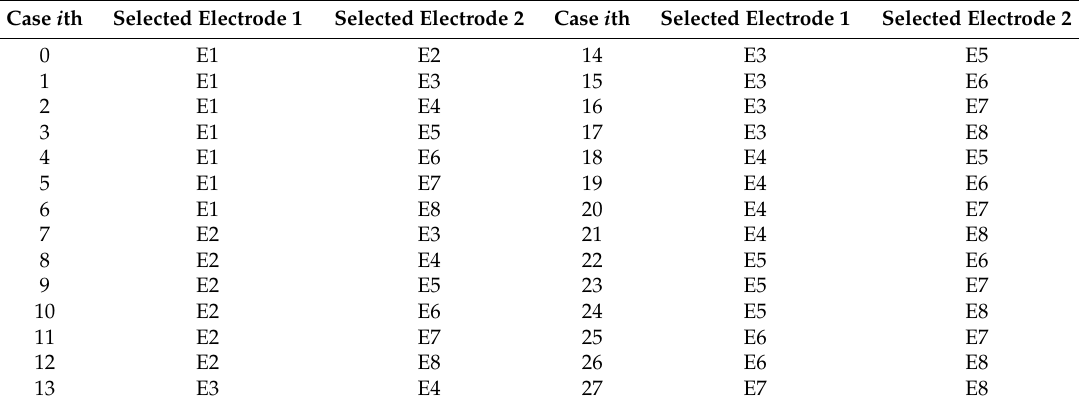
Table 2. Combinations of electrode pairs when using the eight electrodes in the CEHBC system.